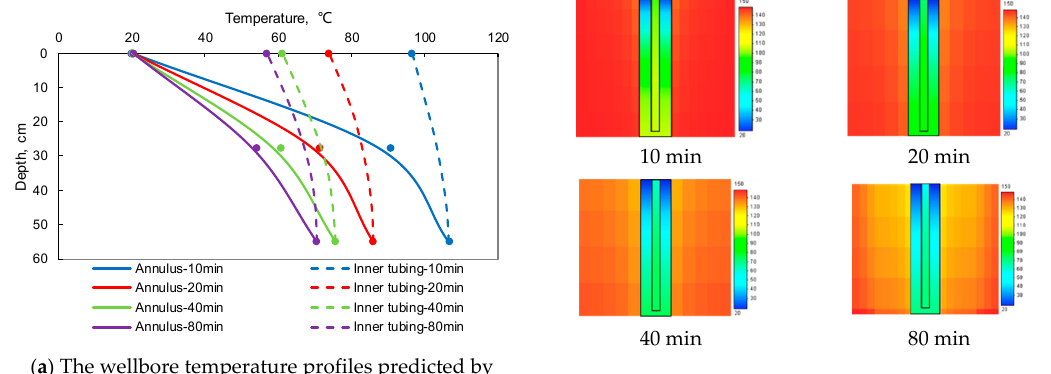
Figure 5. The 3D numerical model of the self ‐ circulation wellbore for heat mining.